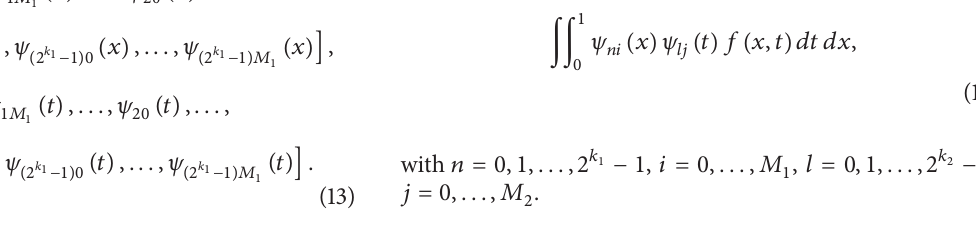
where Ψ(𝑥) and Ψ(𝑡) are 2 𝑘 1 (𝑀 1 +1)×1 and 2 𝑘 2 (𝑀 2 +1)×1 matrices, respectively, given